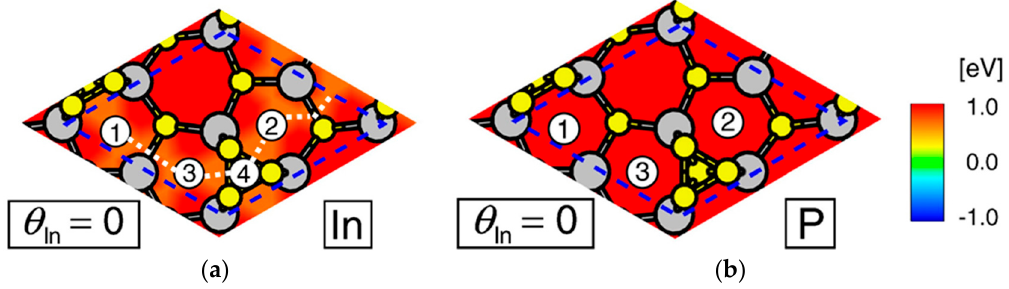
Figure 23. Contour plots of adsorption energies for ( a ) In and ( b ) P atoms on the P trimer surface. These contour plots are indicated by colors with respect to μ gas under the growth condition (B) which is displayed in green region. Atoms tend to adsorb (desorb) in blue (red) colored regions under the growth condition (B). Encircled numbers represent adsorption sites. The coverage of In ( θ In ) and a kind of atom for contour plots are denoted at the lower left and right, respectively. Dotted white lines in ( a ) denotes a possible migration path of In adatom. Reprinted with permission from [98]. Copyright (2013) by Elsevier.